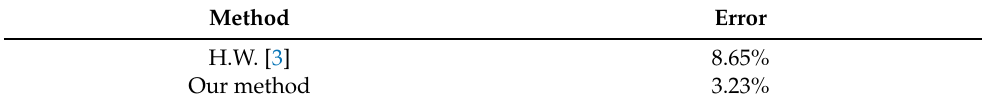
Table 1. Evaluation of estimating VPs on FDWW dataset